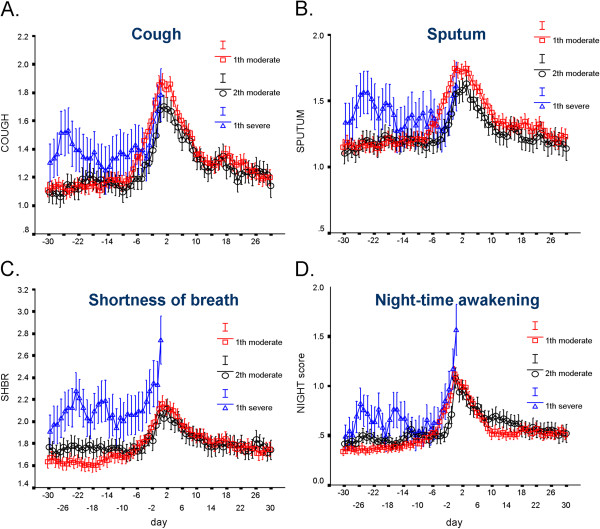
Mean symptom scores (with SEM) for A) Cough, B) Sputum, C) Shortness of breath, and D) Night-time awakening. Based on diary cards according to day number before (days −28 to 0) and after (days 1 to 56) the onset of an exacerbation. Day 0 marks the recorded day of the onset of an exacerbation in the clinical record form. Circles, squares and triangles denote the 1st moderate, 2nd moderate and 1st severe exacerbation, respectively. Outcomes for the 1st severe exacerbation are graphed only up to the day of onset because of many missing values after its onset (when patients were admitted to the hospital).